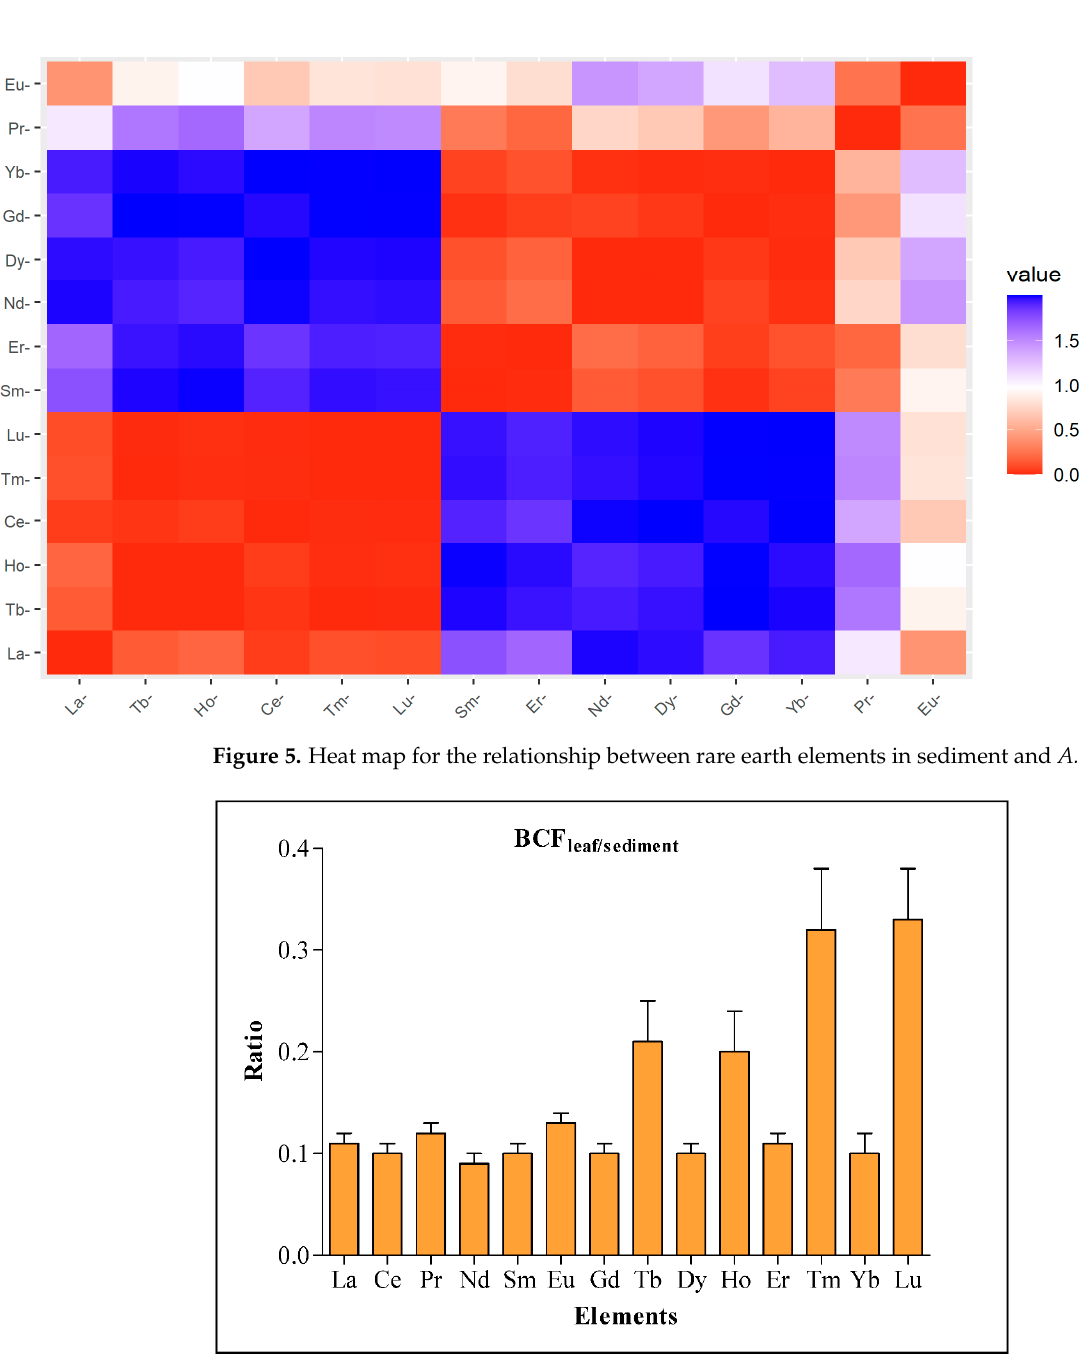
Figure 6. Bio-concentration factor (BCF) for REE composition in northern and southern central Red Sea mangrove ecosystems. Values are mean ± standard error.